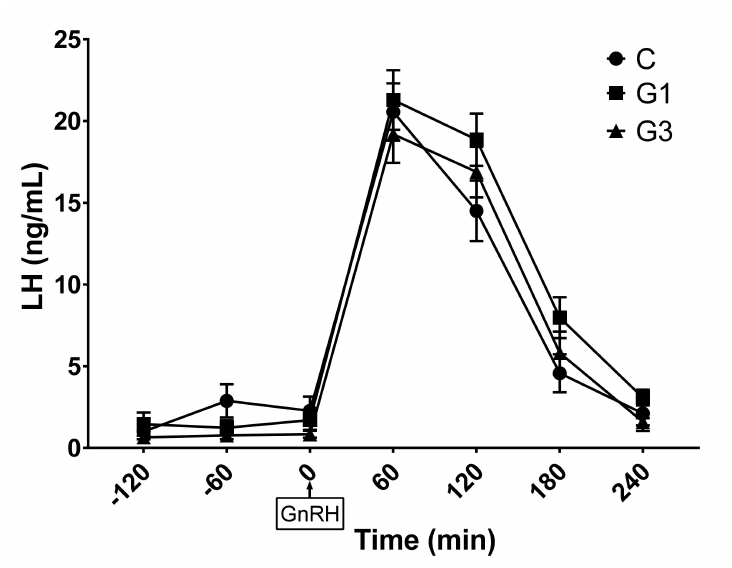
Figure 1. Plasma luteinizing hormone (LH) concentrations from minutes − 120 to 240 after GnRH injection in the control group (C) and does supplemented with 1% (G1) or 3% (G3) of Goji. Values are means and standard